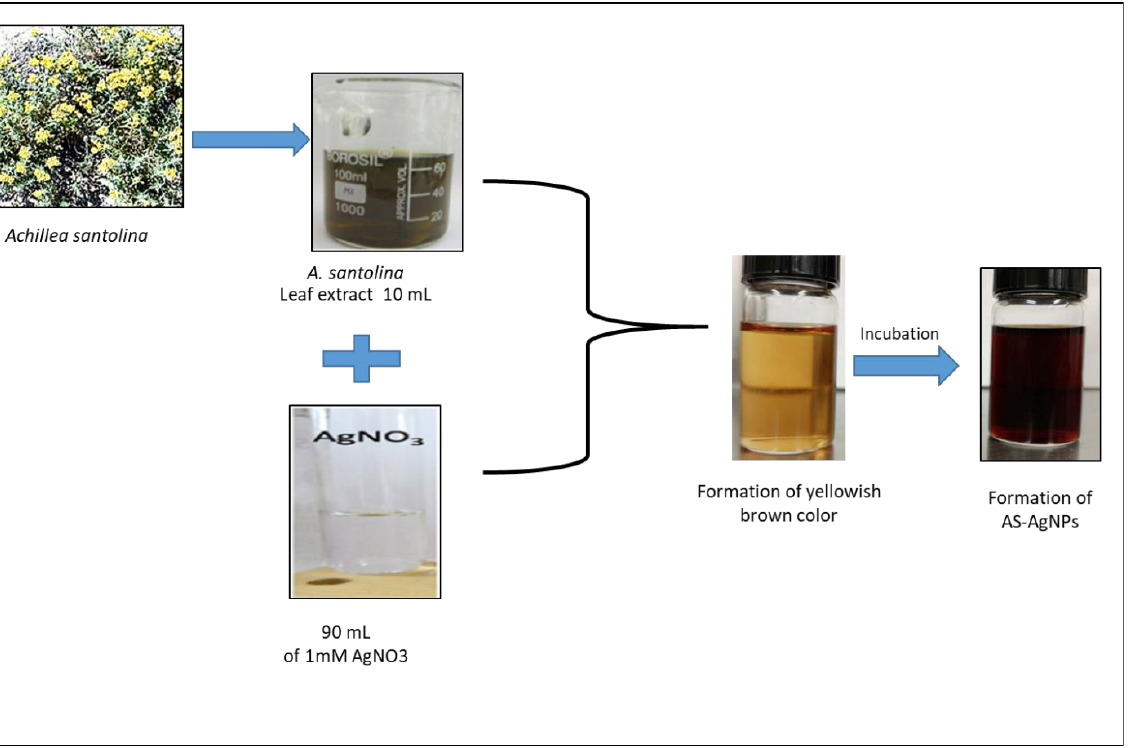
Figure 1. Biosynthesis of AS-AgNPs. Changes in color from yellowish brown to dark brown after the incubation of the A. santolina leaf extract and silver nitrate at room temperature in the